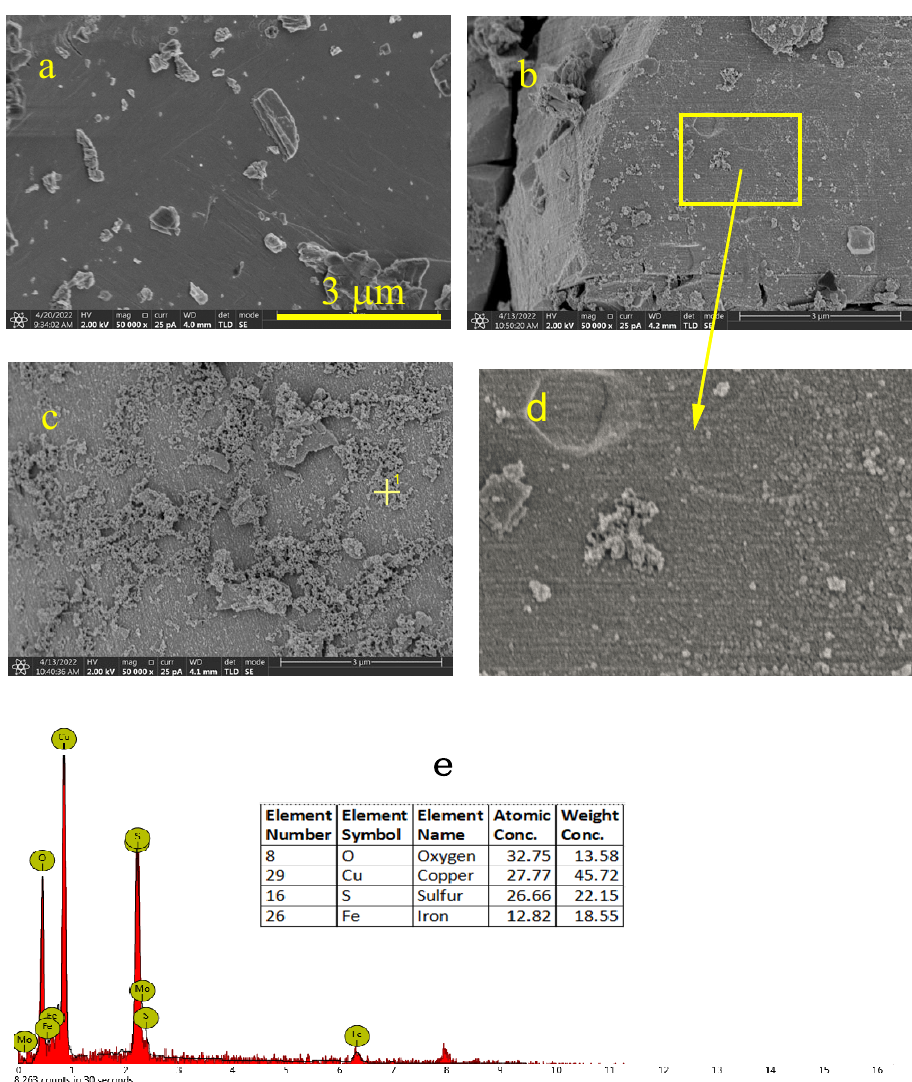
Figure 11. SEM images of the covellite sample: ( a ) fresh sample, ( b ) sample treated with NaClO, ( c ) sample treated with NaClO and FeCl 3 , ( d ) Partial distribution of ( b ), ( e ) EDS result.